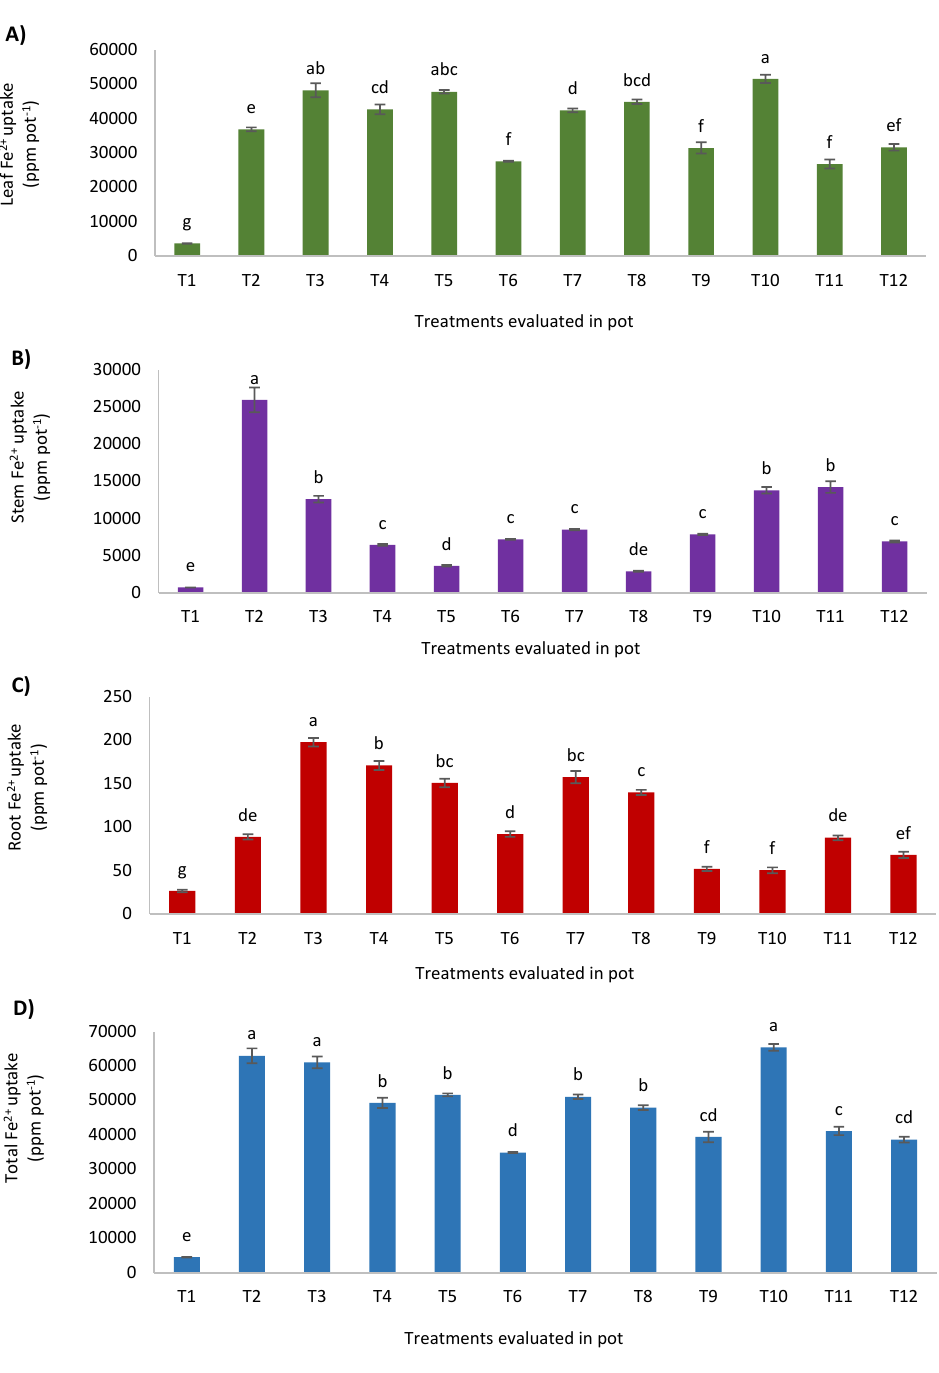
Figure 5. Effects of treatments on iron uptake of ( A ) leaves; ( B ) stems; ( C ) roots; and ( D ) total iron uptake of maize at tasseling stage. Different letters indicate significant difference between means using Tukey’s HSD (Honestly Significant Difference) test at p ≤ 0.05. The error bars are the ± standard error of triplicates.